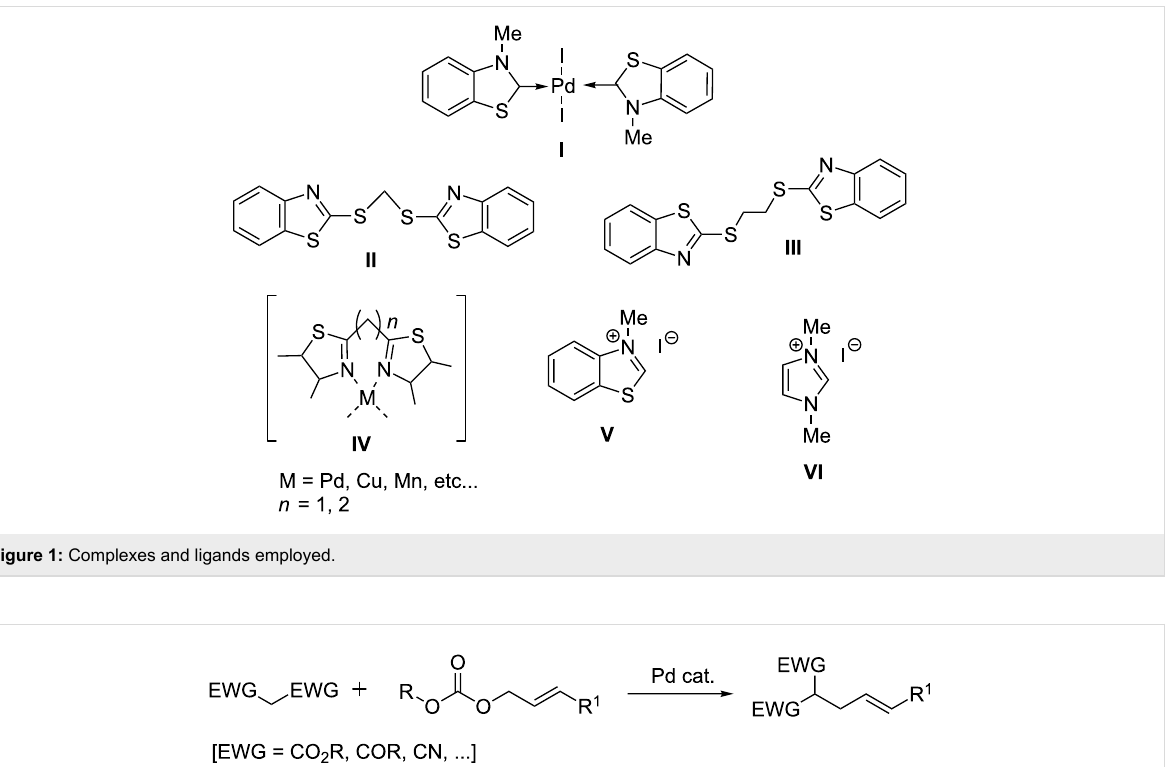
Scheme 1: Pd-catalyzed α -allylation of active methylene